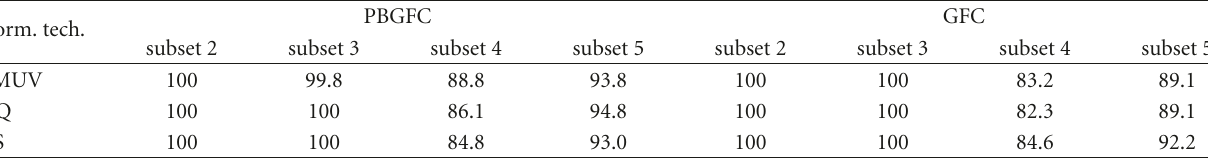
Table 2: Comparison of the impact of di ff erent normalization techniques on the rank one recognition rates (in %) on the EYB database. Norm. tech.